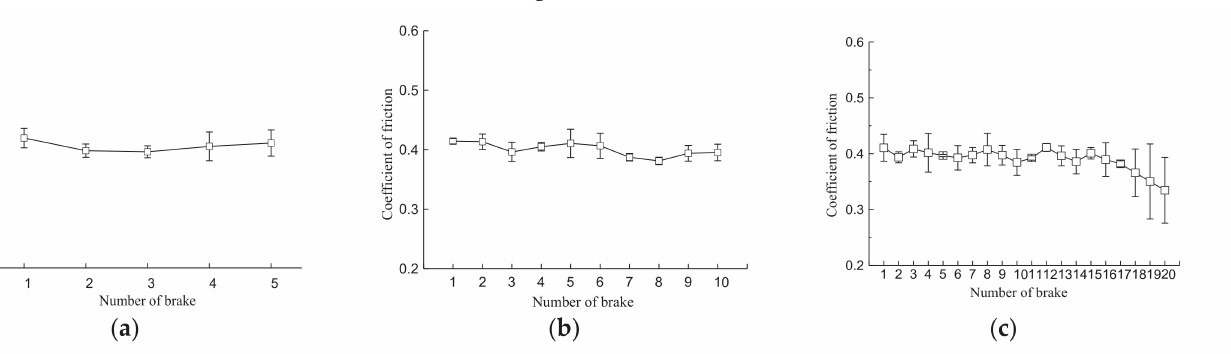
Figure 14. Coefficients of friction between the brake disc and the brake shoe with different numbers of emergency braking cycles. ( a ) 5 cycles ( b ) 10 cycles ( c ) 20